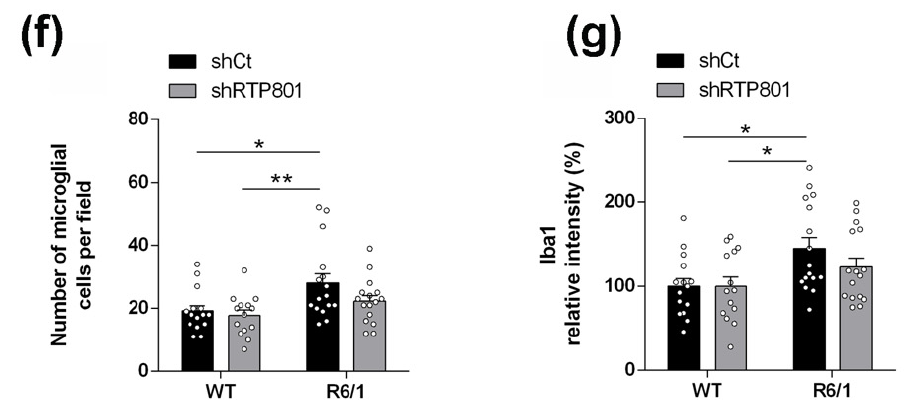
Figure 4. Silencing hippocampal RTP801 neuronal levels in R6/1 mouse partially prevents neuroinflammatory events. ( a ) Representative GFAP and RTP801 labelling in the CA1 hippocampal region in 5-month-old WT and R6/1 mice (upper panels, scale bars 50 µm and lower panels, 25 µm). ( b ) Quantification of GFAP levels (IOD intensity, % respect to WT shCt) in the four groups (treatment effect: F (1, 39) = 9.363, p = 0.0040; genotype effect: F (1, 39) = 0.09983, p = 0.7537). ( c ) Quantification